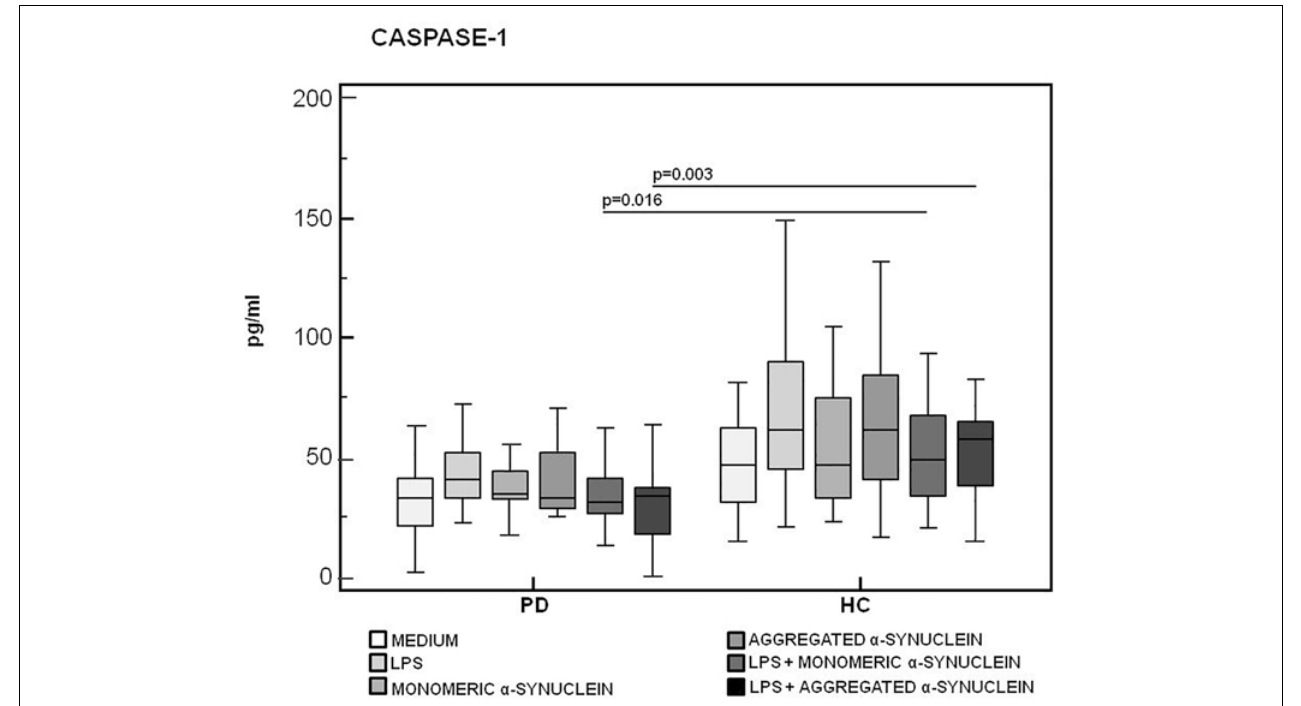
FIGURE 3 | Modulation of active caspase-1 (p20) protein by LPS-primed and monomeric or aggregated α -synuclein–stimulated cells of PD and HC subjects. Caspase-1 production was assessed by enzyme-linked immunosorbent assay in supernatants of unstimulated, LPS-stimulated, monomeric α -synuclein–stimulated, aggregated α -synuclein–stimulated, LPS-primed and monomeric α -synuclein–stimulated, or LPS-primed and aggregated α -synuclein–stimulated cells of 15 Parkinson disease (PD) patients and 15 healthy controls (HC). Summary results are shown in the bar graphs. The boxes stretch from the 25th to the 75th percentile; the line across the boxes indicates the median values; the lines stretching from the boxes indicate extreme